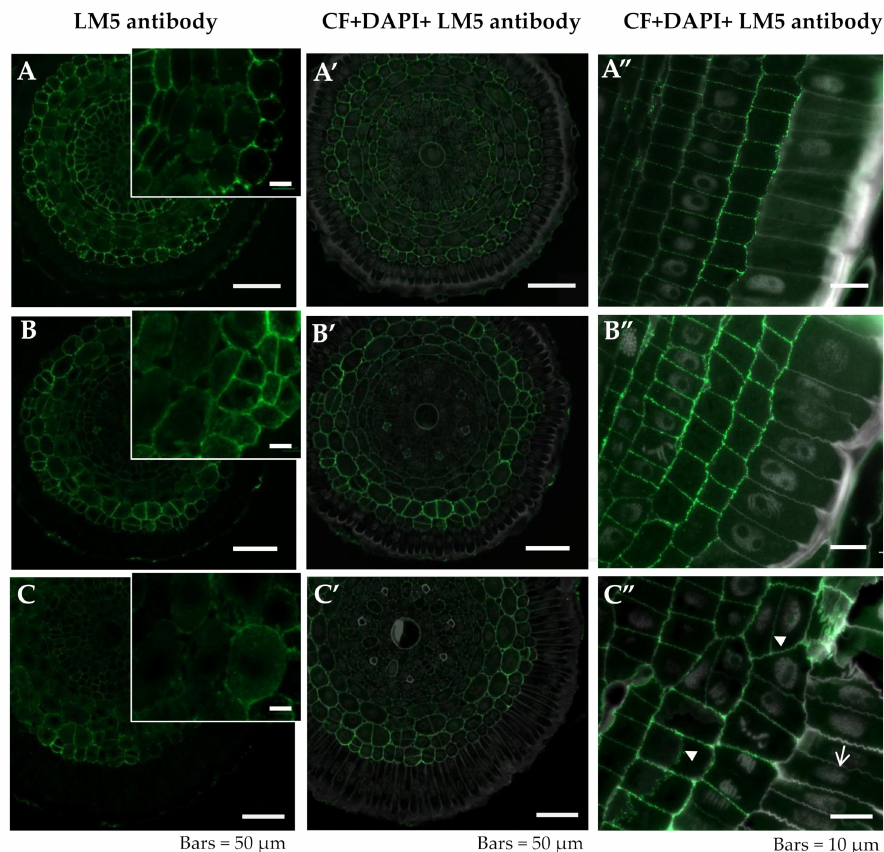
Figure 2. Distribution of LM5 epitope in cross sections in di ff erentiated zone ( A , A’ – C , C’ ) and longitudinal sections in meristematic zone ( A” – C” ) of root tissues of barley cv. Sebastian. ( A – A” )—control pH 6; ( B – B” )—control pH 4; ( C – C” )—30 µ M AlCl 3 . ( A – C )